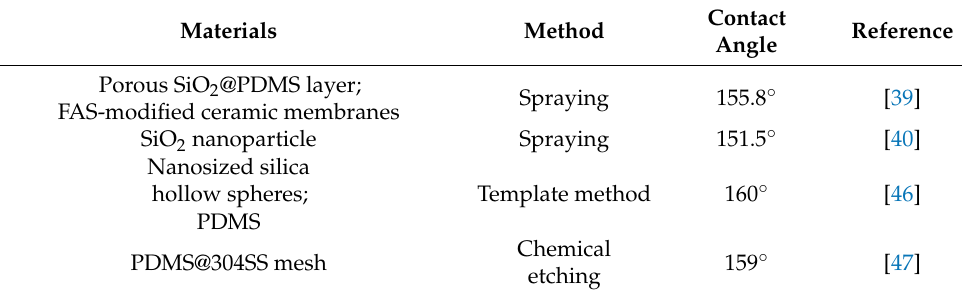
Table 2. Standard hydrophobic surfaces from literature.